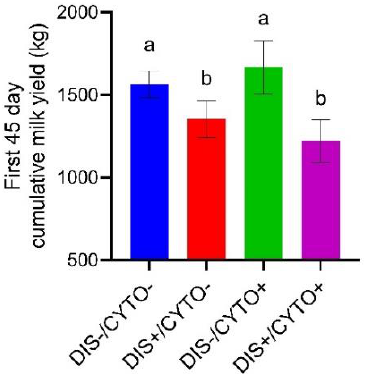
Figure 4. First 45-day cumulative milk yields (means and 95% CI) in 119 multiparous Holstein cows stratified by disease (DIS) and cytological endometritis (CYTO) statuses (DIS − /CYTO − = disease-negative/CYTO-negative; DIS+/CYTO − = disease-positive/CYTO- negative; DIS − /CYTO+ = disease-negative/CYTO-positive; DIS+/CYTO+ = disease-positive/CYTO- positive). Different letters indicate statistical significance at p-values <